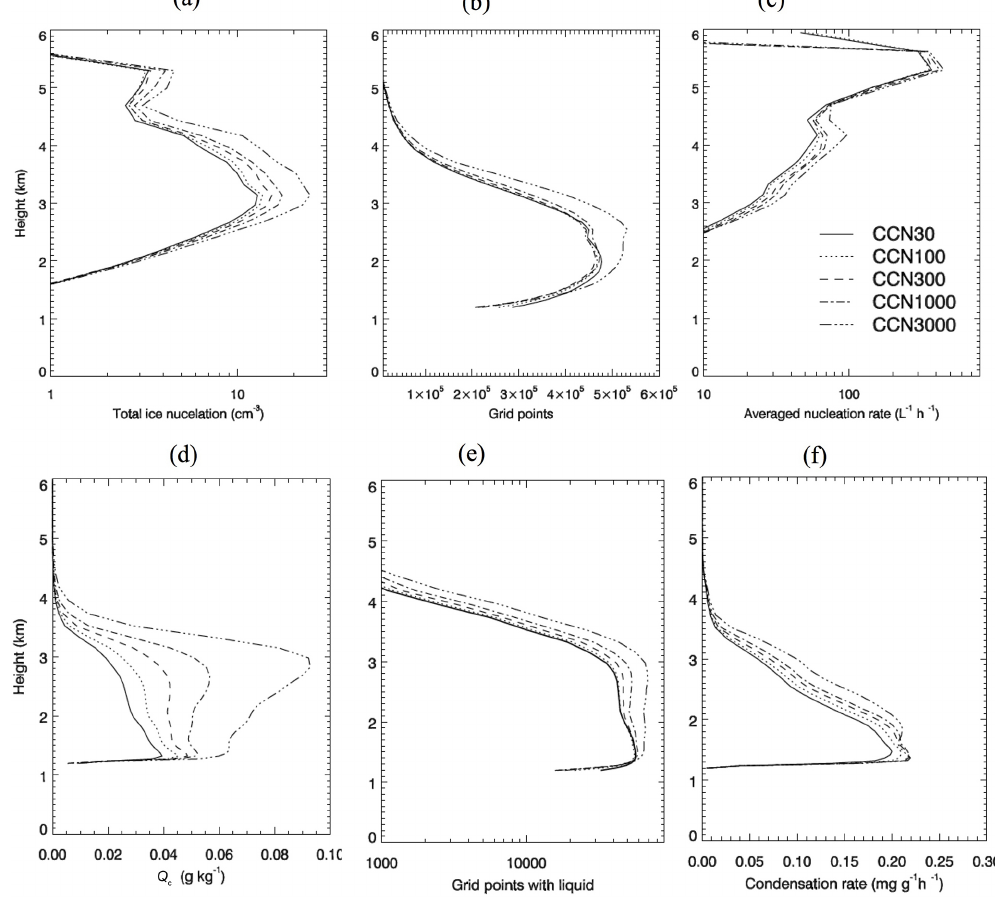
Figure 6. Vertical profiles of (a) total nucleated ice particles, (b) the total grid points where ice nucleation occurs, (c) the ice nucleation rate averaged over the total ice nucleation grid points, (d) domain-mean cloud water content ( Q c ) , (e) the total grid points that have liquid (i.e., the liquid water mixing ratio is larger than 10 − 5 kgkg − 1 ) , and (f) the domain-mean condensate rate during 14:00–16:00UTC for the